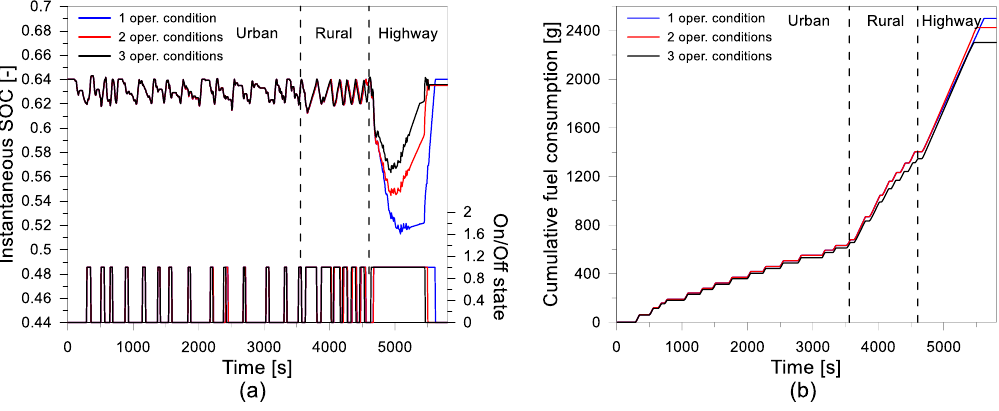
Figure 12. Instantaneous SOC ( a ) and cumulative fuel consumption ( b ) for the three-charging strategy during the real driving cycle (RDE) driving cycle.